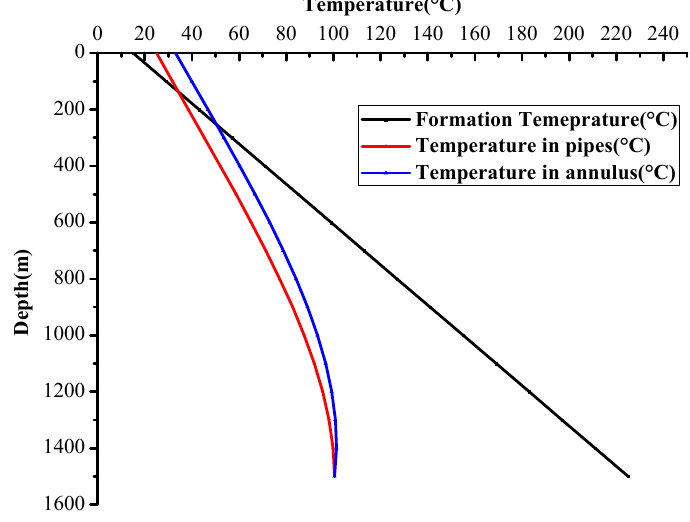
Figure 4. The temperature profile in the pipe and annulus (circulating 1 h).